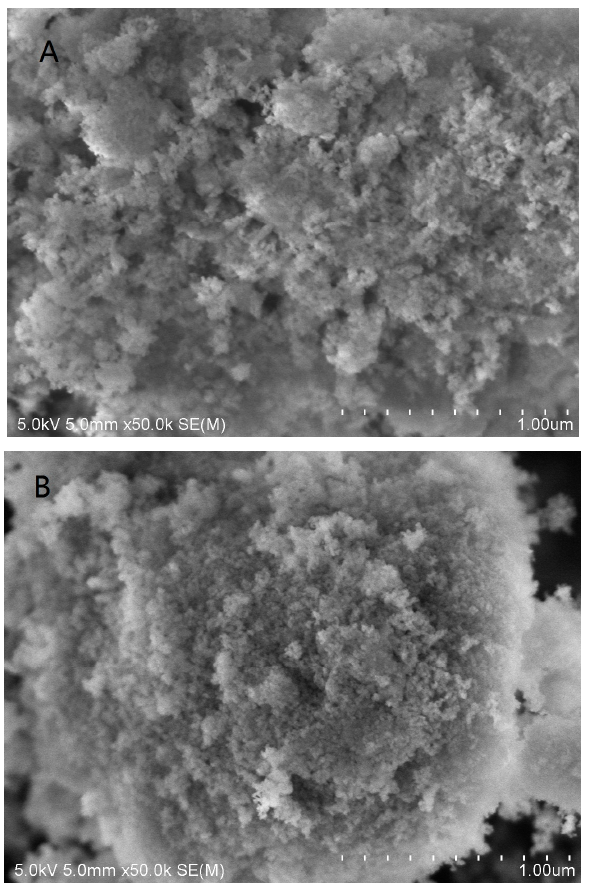
Figure 4. SEM (scanning electron microscope) images of catalysts ( A ) the fresh catalyst and ( B ) the used catalyst.